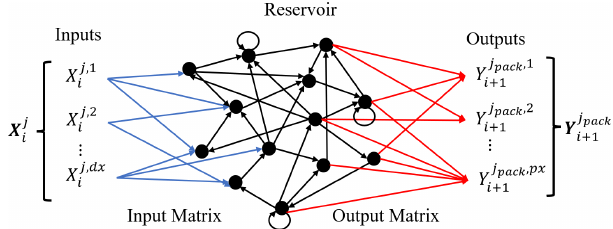
Figure 3. Illustration of the architecture of the j th reservoir com-